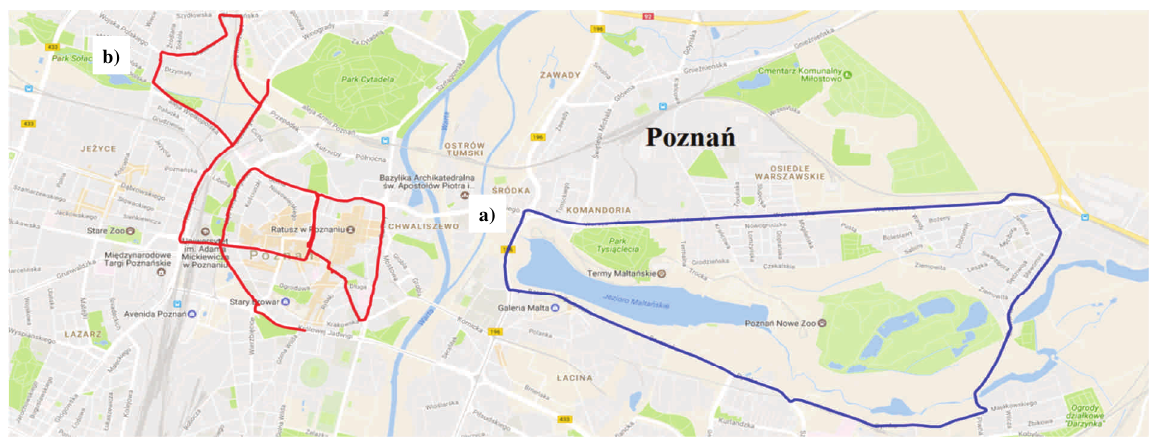
Fig. 2. Routes used in RDE tests: a) route No. 1 for vehicle A and B, b) route No. 2 for vehicle C [11]